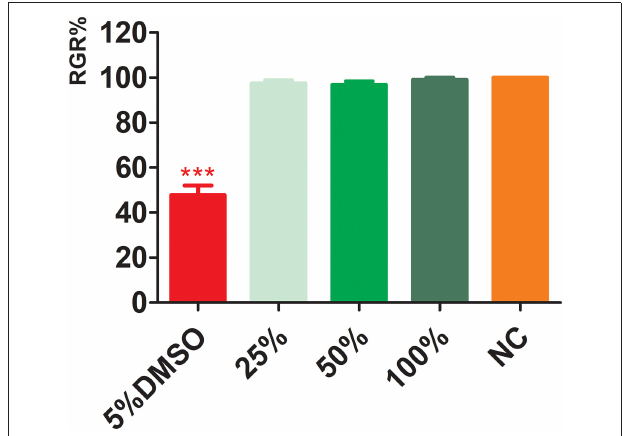
FIGURE 4 | Cytotoxicity of electrospun membrane extracts. DMSO, dimethyl sulfoxide; NC, negative control. *** p < 0.001.